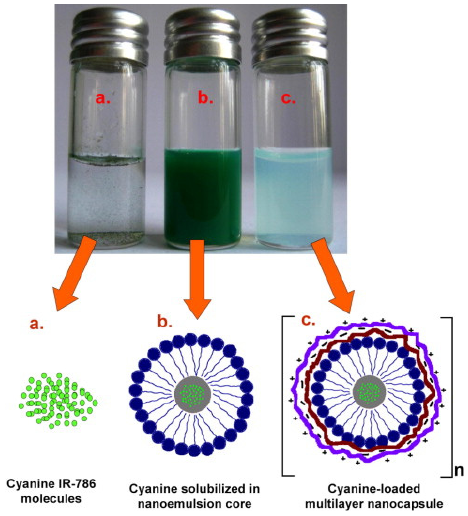
Figure 11. Cyanine IR-786 ( a ) dispersed in water, ( b ) solubilized in bare nanoemulsion, and ( c ) encapsulated in nanoemulsion coated by (PSS-PDADMAC) 4.5 . Reprinted with permission from reference [297] . Copyright (2012), with permission from Elsevier.